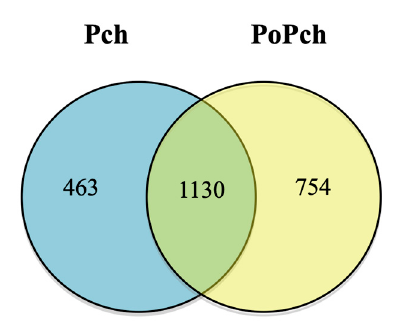
Figure6. Phaeomoniellachlamydospora Figure 6. Phaeomoniella chlamydospora transcripts detected by RNAseq analysis in grapevine wood tissues according to the treatment (Pch: P. chlamydospora ; PoPch: Pythium oligandrum and P. chlamydospora ).